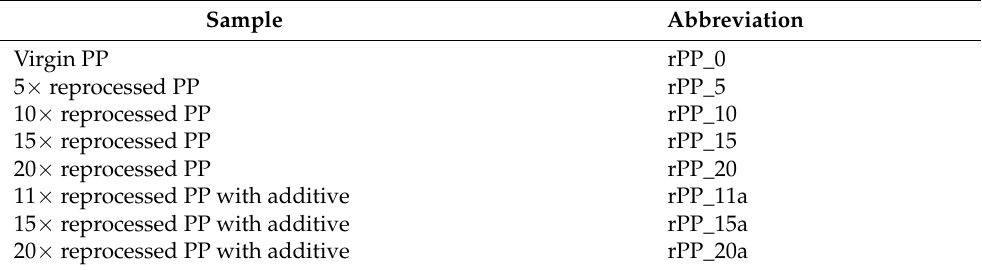
Table 1. Sample classification and corresponding abbreviations. Sample Abbreviation